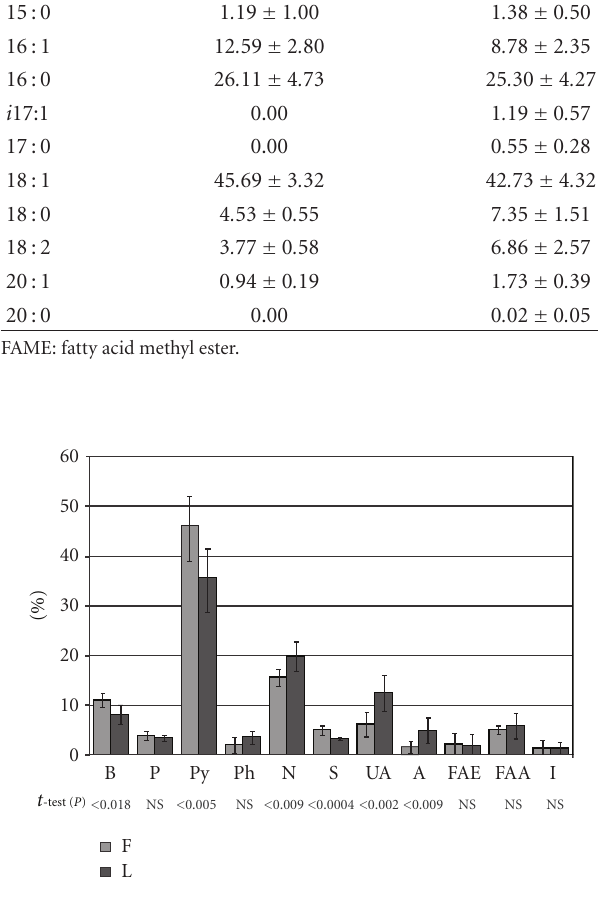
Figure 2: Quantitative relations between the main groups of ther- molysis products derived from the components of the compact part of human bone preserved by deep-freezing (F) or lyophilization (L) and classified according to their chemical